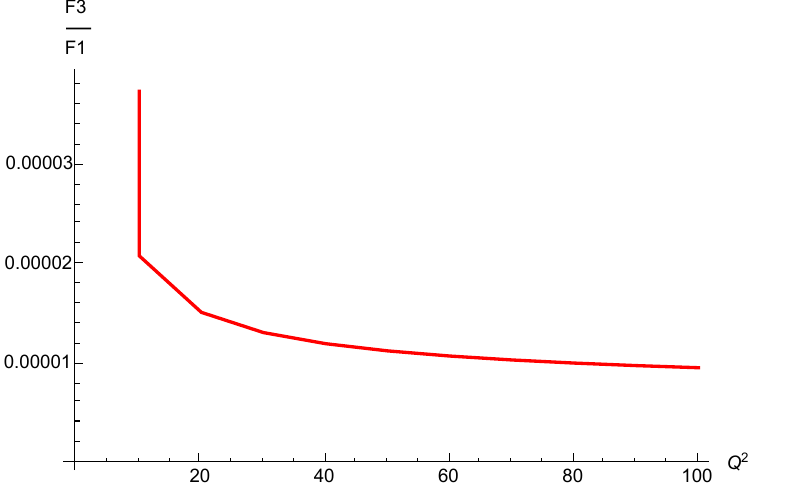
Figure 15. The form factor ratio: abnormal state No. 3/normal state No. 1 from Table 1. (Adapted from